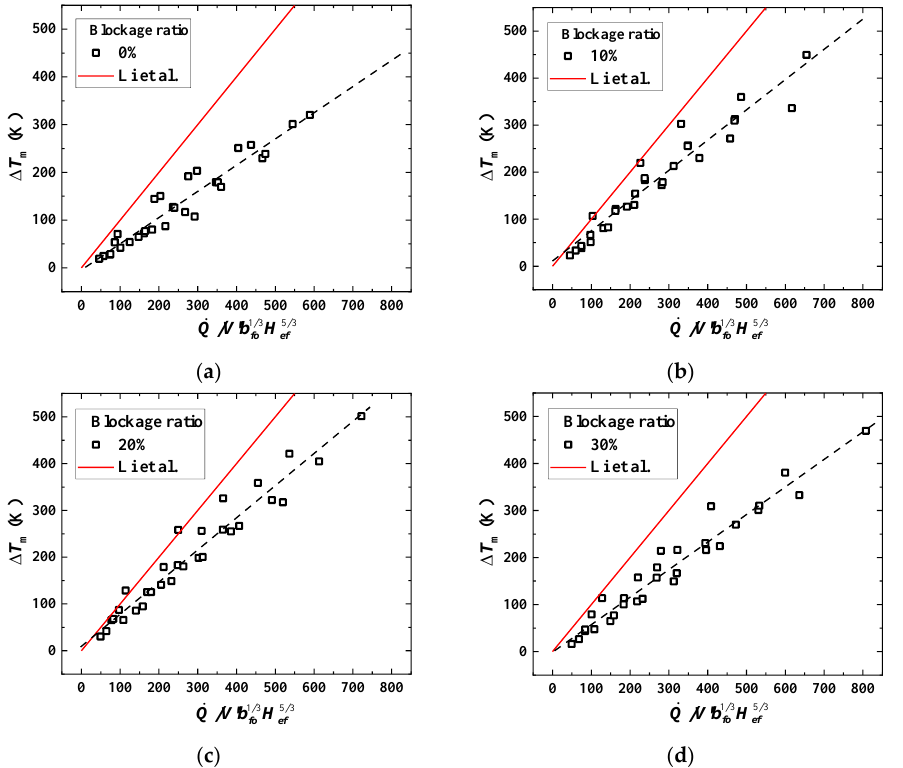
Figure 10. Fitting of maximum temperature rise with different blockage ratios: ( a ) φ = 0%; ( b ) φ = 10%; ( c ) φ = 20%; ( d ) φ =